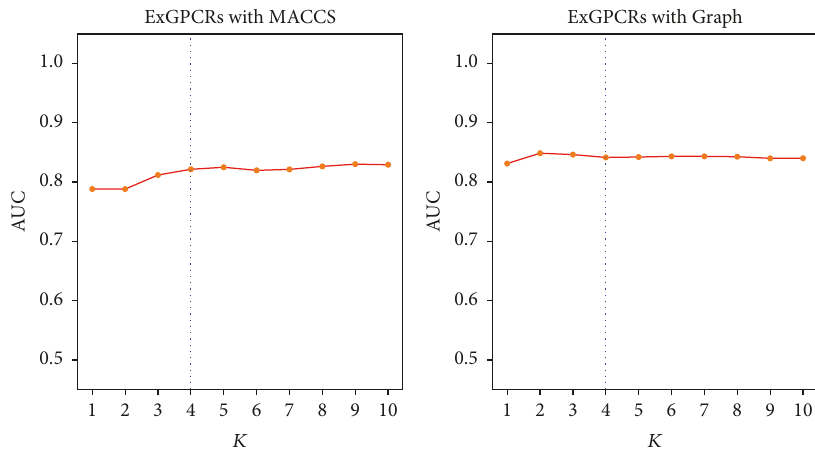
Figure 2: Robustness of SDTRLS with respect to the number of 𝐾 : the dotted line is the default value and its prediction performance.